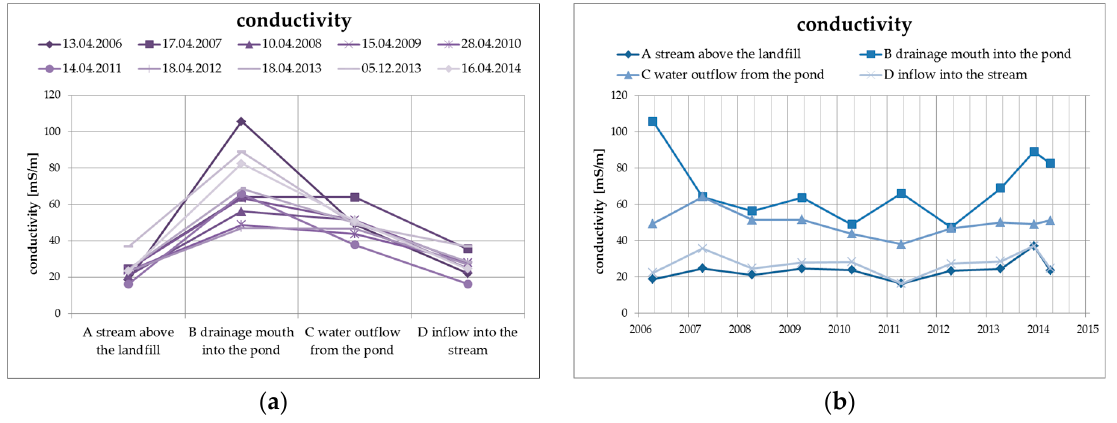
Figure 5. Change of values of specific conductivity in surface water depending on the monitored profile ( a ) and time ( b ).